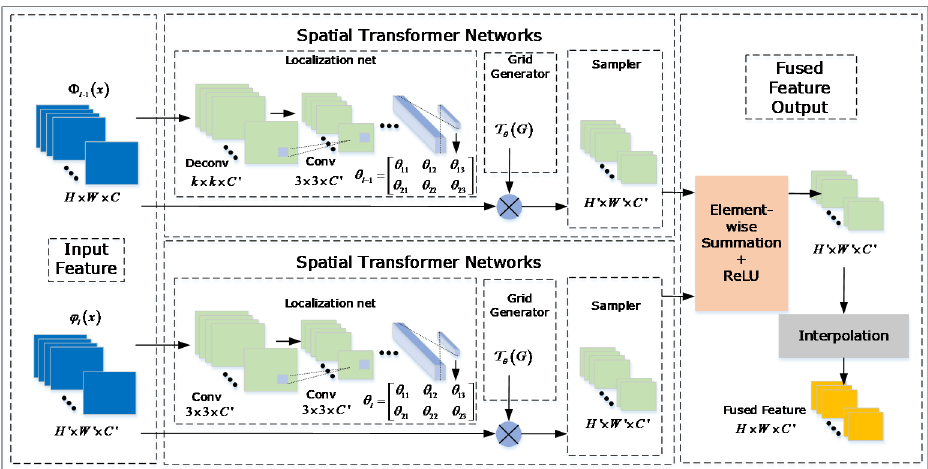
Figure 5. Flow chart of the feature extraction model though the spatial transformer network (STN). We employ the STN in order to transfer features to next stage and ensure dimension of feature simultaneously.